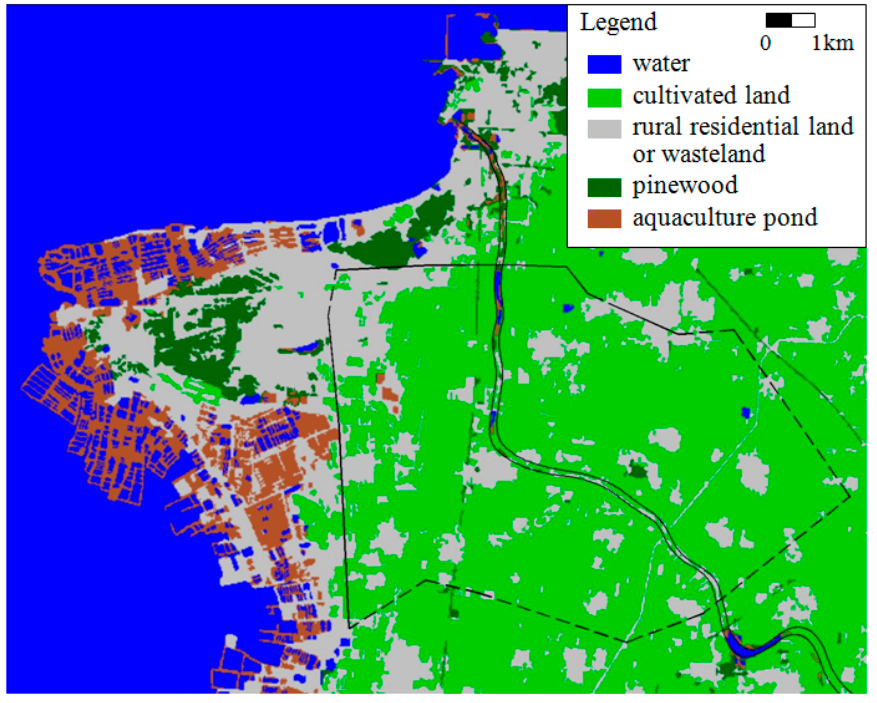
Figure 2. Land use pattern of the study area.